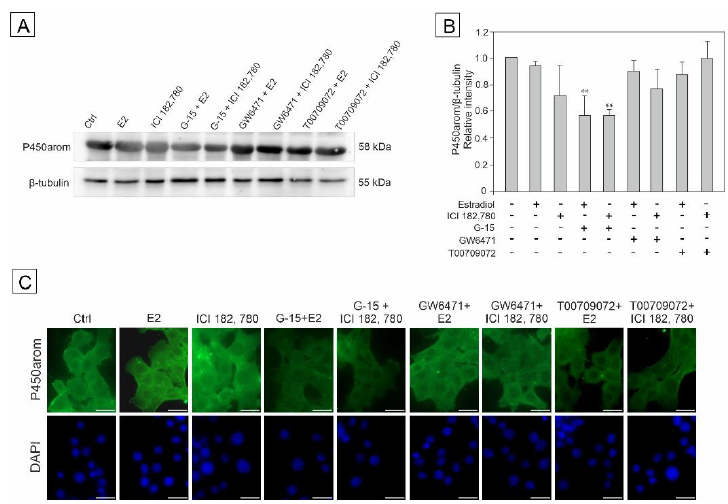
Figure 7. The effect of estradiol (E2), GPER agonist (ICI 182,780), GPER antagonist (G- 15), PPARα antagonist (GW6471), and PPARγ antagonist (T00709072) on P450arom protein expression in MA-10 cells ( A – C ). Representative blots of Western analysis ( A ), relative expression of the protein ( B ), and immunofluorescent localization of the enzyme ( C ). Cells were harvested after 24 h. Untreated cells served as a control. Protein levels within control cells were given a value of 1. The cropped blots are displayed and the original blots are provided in Supplementary Materials (Figure S1). The relative levels of the proteins were normalized to β -tubulin, which served as the internal protein loading control. The histograms are the quantitative representation of data (mean ± SD) of three independent experiments, each in triplicate ( B ) . The scale bar = 20 µm ( C ) . A plus sign (+) indicates the presence of the compound in the culture medium, a minus sign ( – ) indicates no compound in the culture medium. Asterisks indicate significant differences from control cells. Values are denoted as * p < 0.05, ** p < 0.01 and *** p < 0.001.